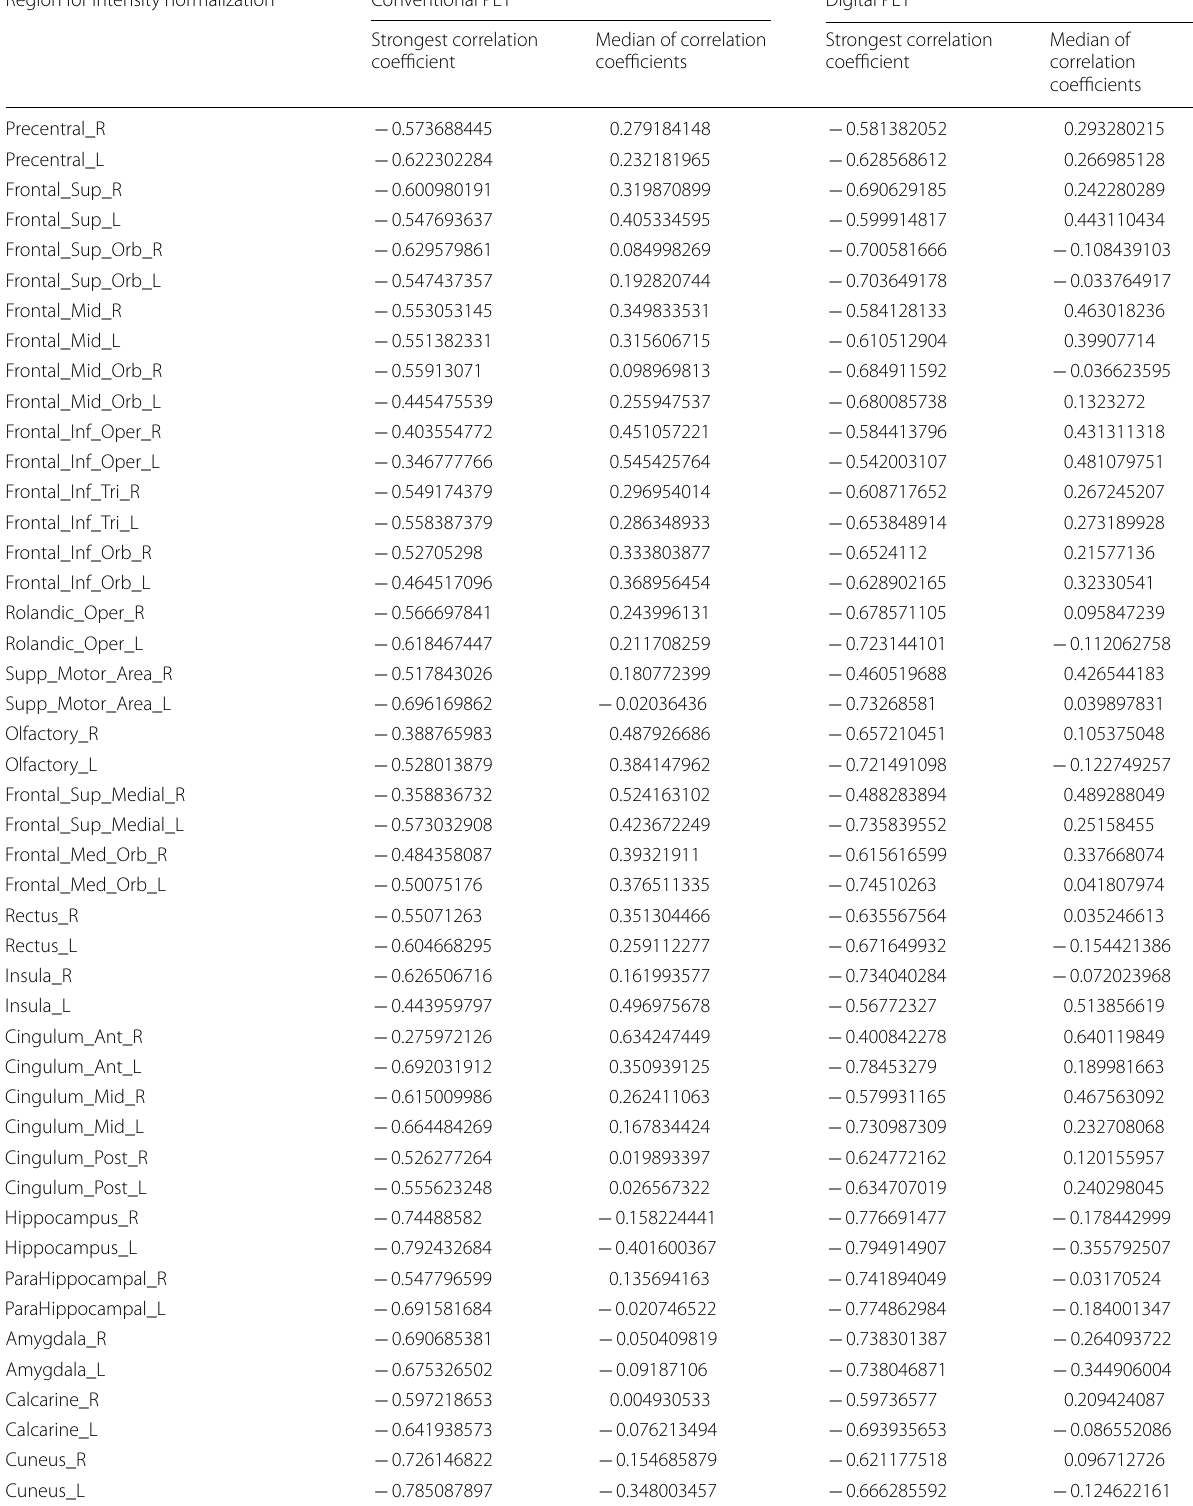
Table 1 Median and highest Pearson correlation coefficients (provided from correlation coefficients of the 120 brain regions) between PET metabolism and age for each region of intensity normalization in both conventional and digital PET systems Region for intensity normalization Conventional PET Strongest correlation